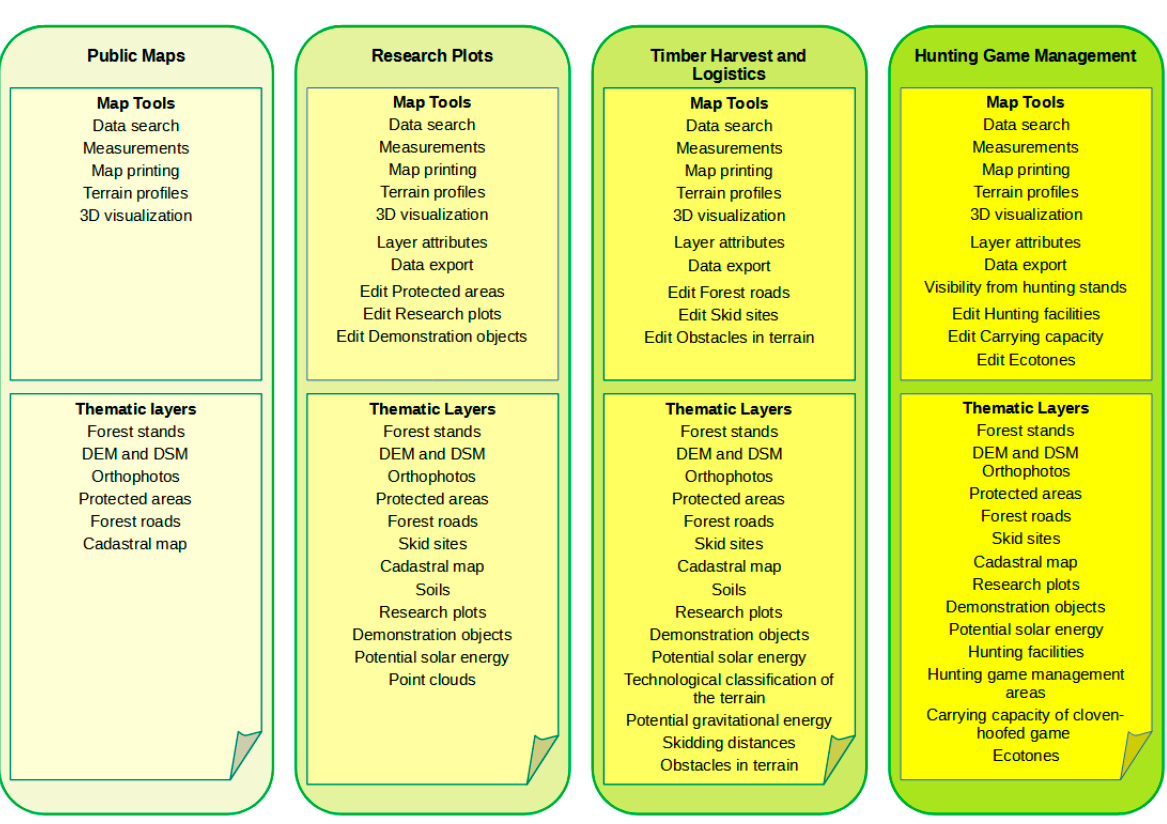
Figure 6. Schematic diagram of the web map applications.